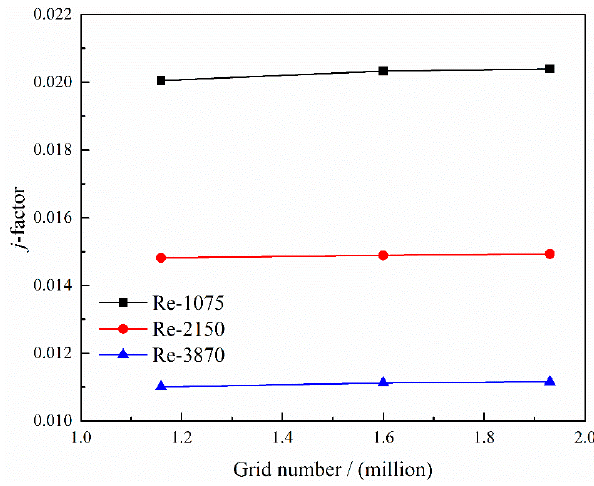
Figure 3. Change in the j -factor in accordance with the change of grids number. Energies 2018 , 11 , x FOR PEER REVIEW